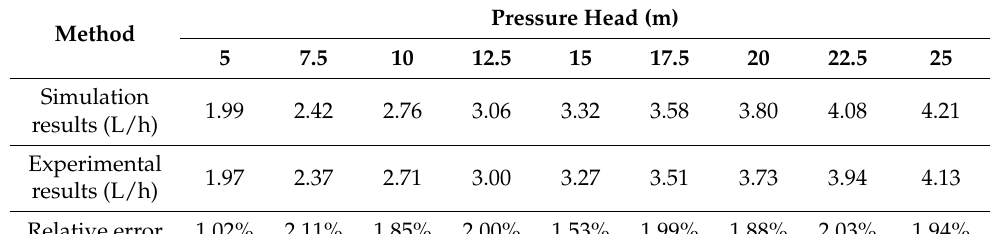
Table 2. The relative error of the flow rate.